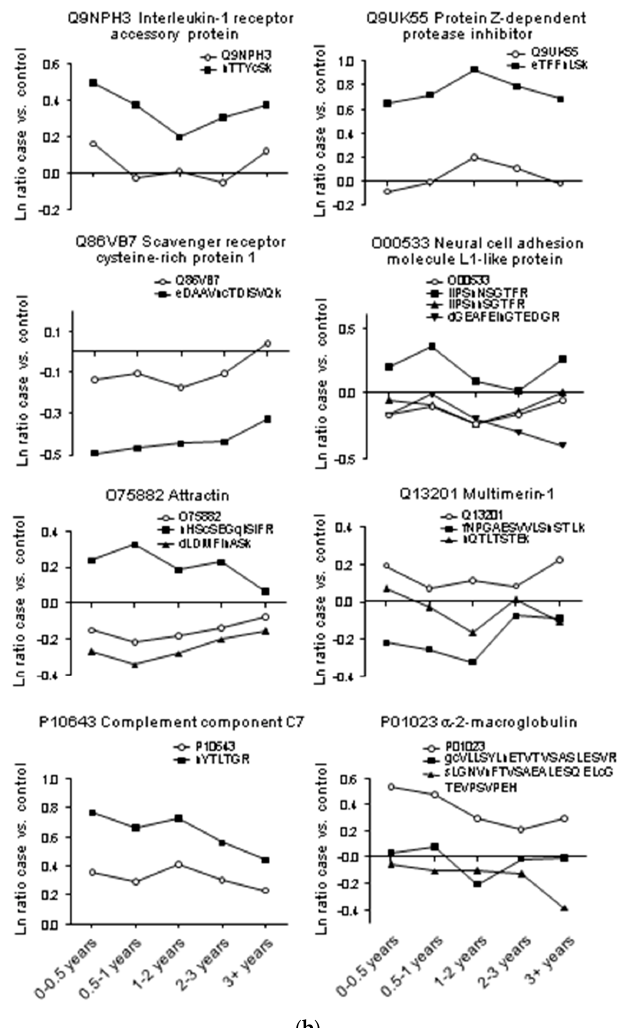
Figure 2. ( a ) Examples of altered glycoproteins whose constituent glycopeptides match the pattern of expression of their parent protein; ( b ) Examples of glycoproteins whose constituent glycopeptides deviate from the pattern of expression of their parent protein. Graphs show the median natural log (ln) ratio of case versus control for protein (open circles) at each time group prior to diagnosis of pancreatic cancer. Protein ratios were derived from TMT reporter ion intensity ratios for all peptides matching that protein. Closed symbols show ln ratio for case versus control across time groups for specific glycopeptides matching those proteins. Some examples show the same peptide sequence with different deamidation (N and Q) modifications.